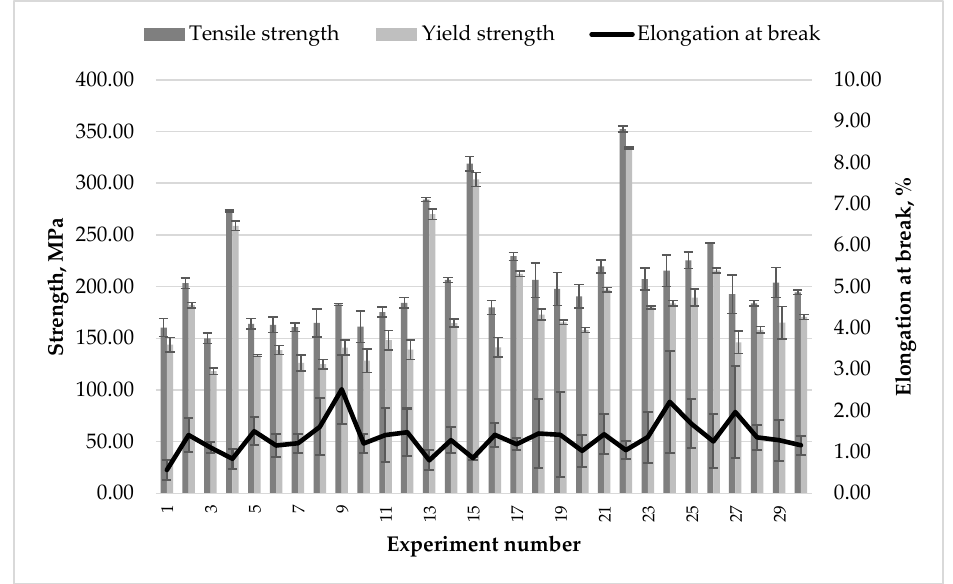
Figure 2. The mean values and standard deviations of the measured results for tensile strength, yield strength and elongation at break of the flat samples.